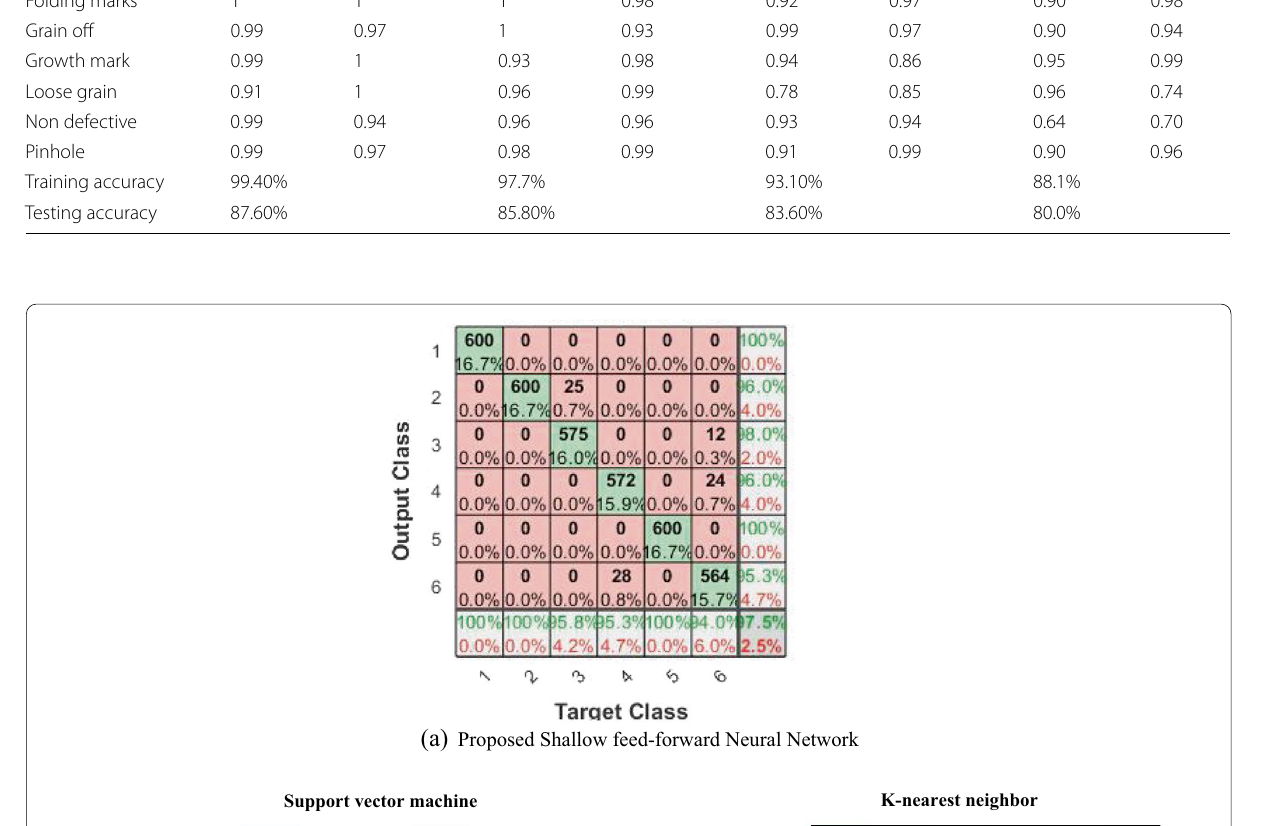
Fig. 13 Comparision of classification accuracy of the machine learning